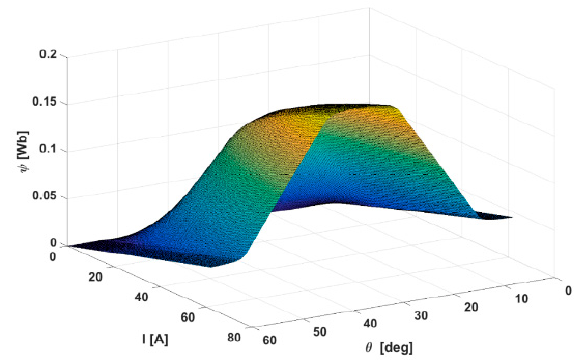
Figure 1. Flux in terms of position and phase current.